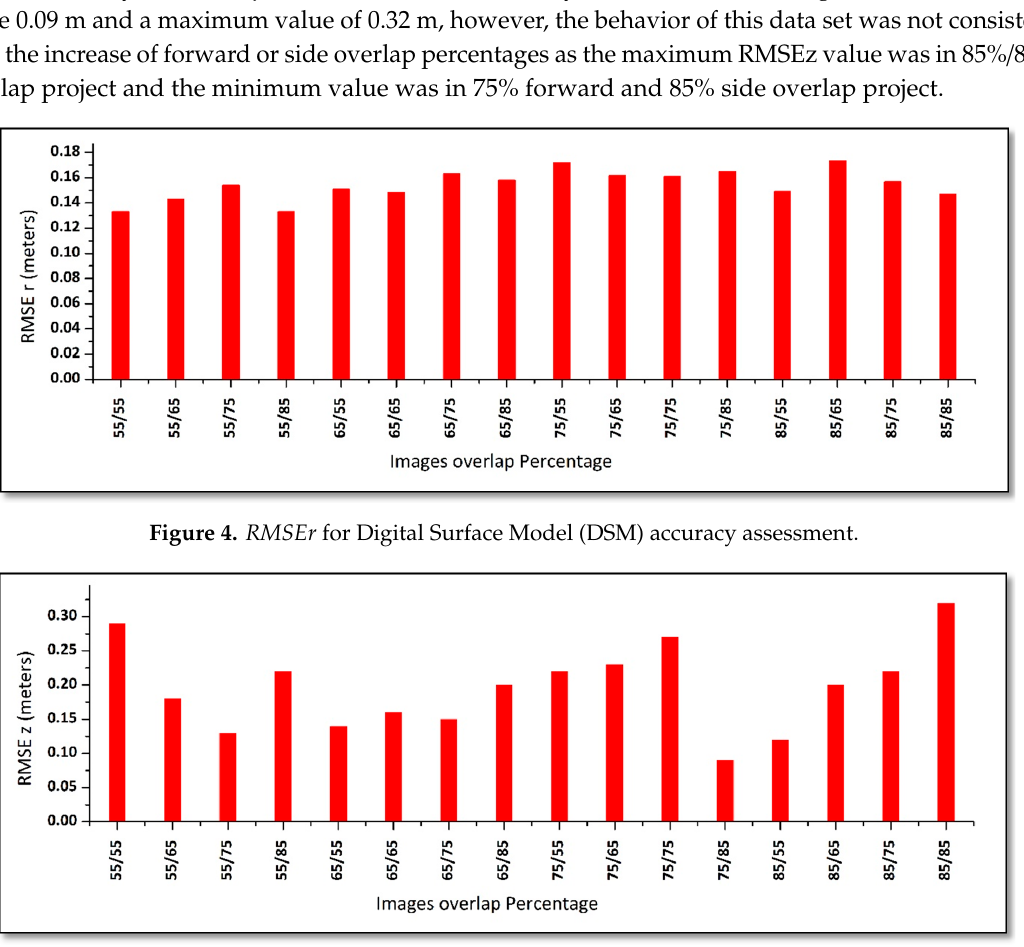
Figure 5. RMSEz for DSM accuracy Figure 5 . RMSEz for DSM accuracy assessment.